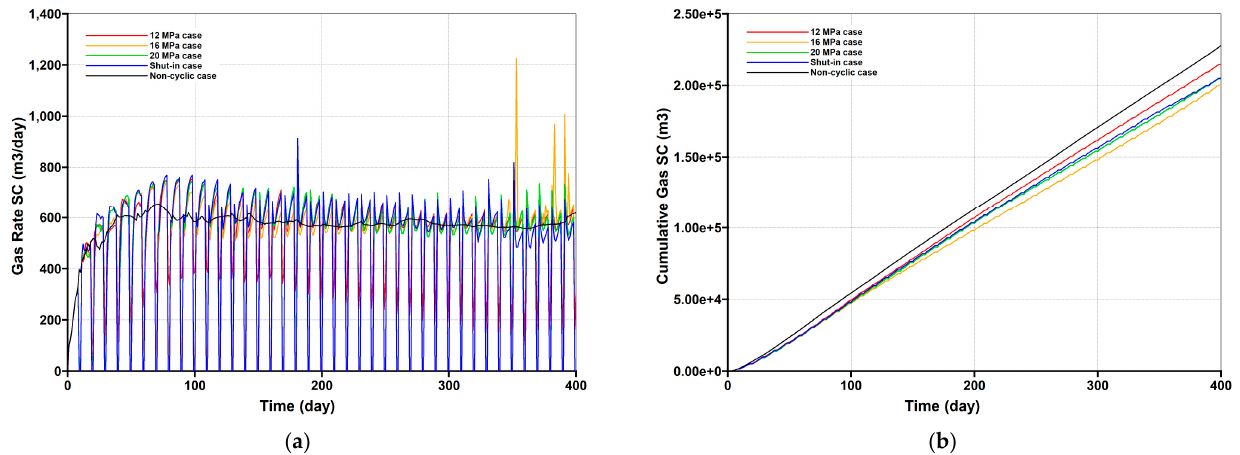
Figure 13. Results of gas production by use of different bottomhole pressure during secondary depressurization stage: ( a ) gas production rate and ( b ) cumulative gas rate.